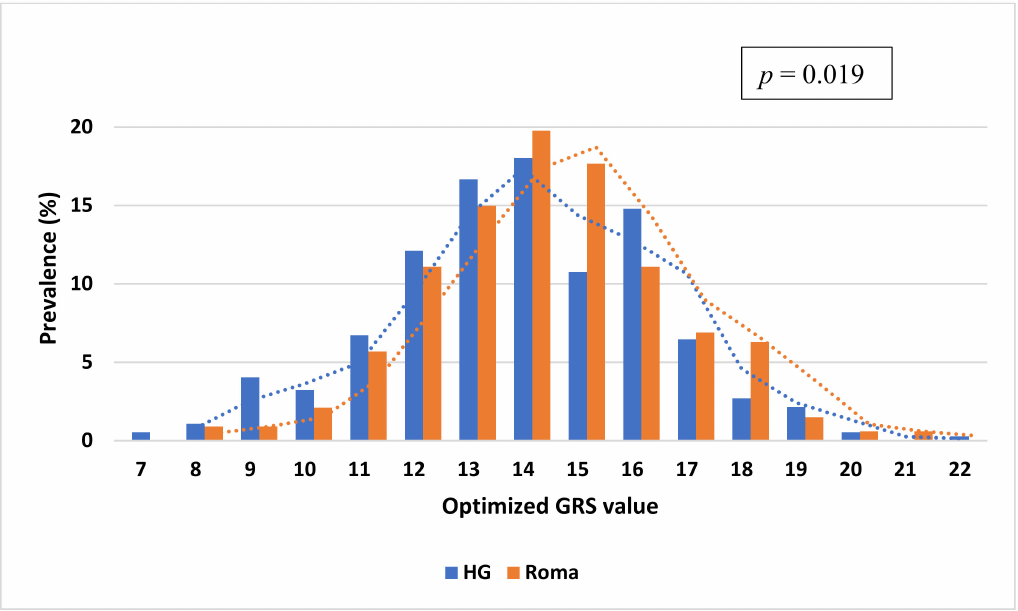
Figure 2. Distribution of genetic risk score optimized for HOMA—IR based on fifteen single nu- cleotide polymorphisms (selected in the GRS optimization process) in the Roma and Hungarian general (HG)